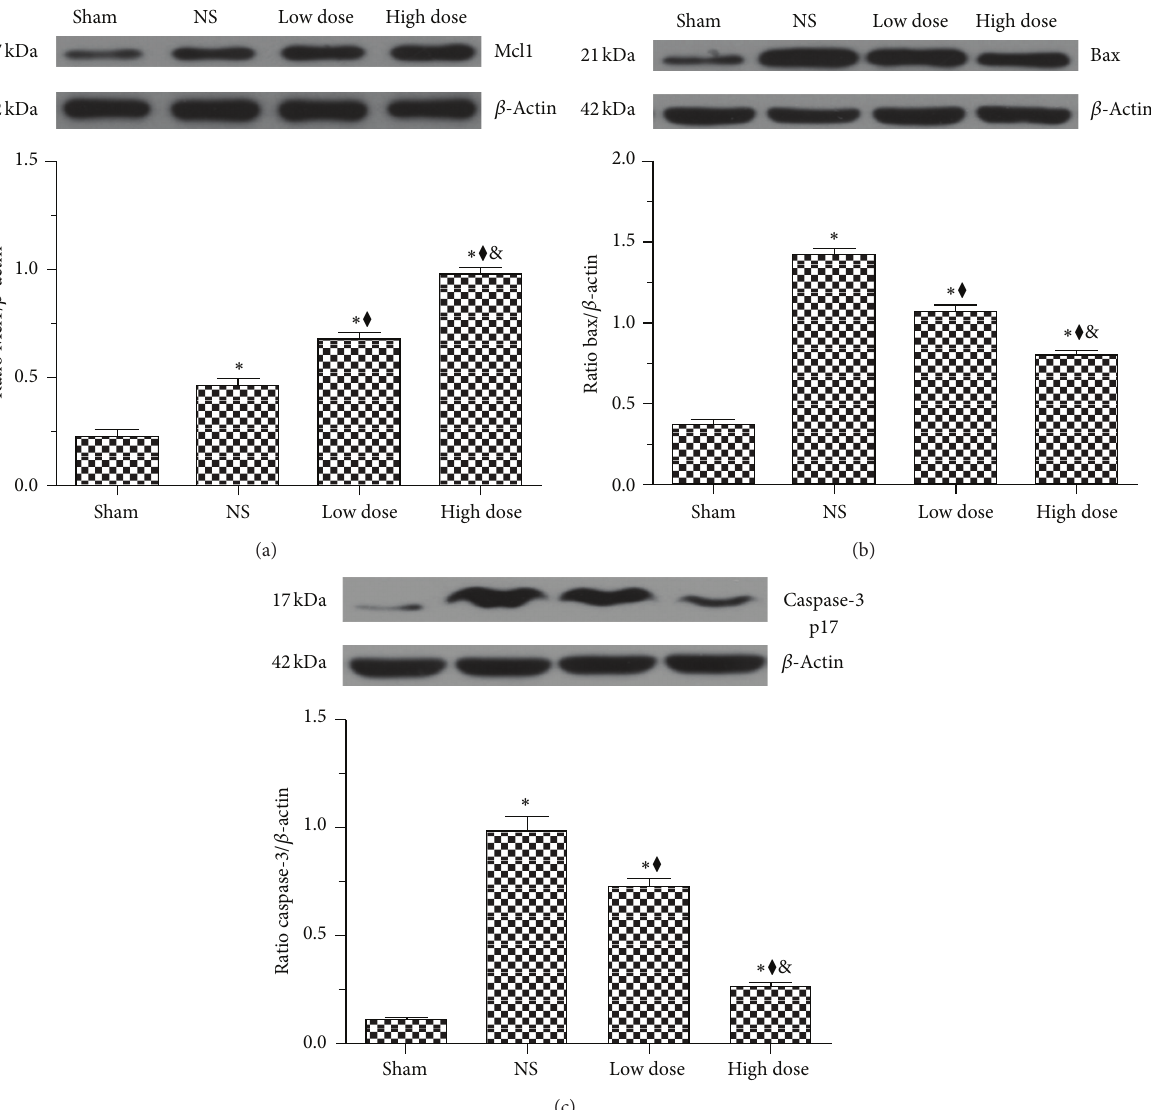
Figure 5: Scutellarin treatment upregulated Mcl1 and suppressed Bax, caspase-3 p17 expression. Western immunoblot analysis of protein levels of (a) Mcl1, (b) Bax, and (c) cleavedcaspase-3 p17 in the rat cortex and striatum. Scutellarin significantly upregulated Mcl1 but dose- dependently decreased Bax and cleavedcaspase-3 p17 (c). ∗ 𝑃 < 0.001 versus sham group; ⧫ 𝑃 < 0.001 versus NS group; & 𝑃 < 0.001 versus low-dose